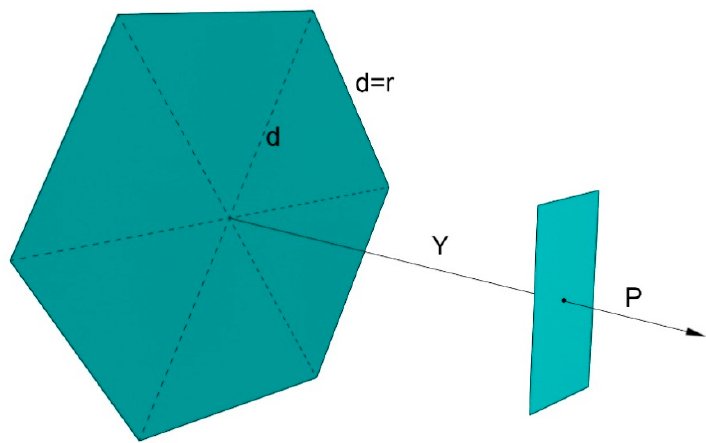
(A7) Figure A2. Configuration factor between an equilateral triangle composed of six rotated triangles and a point in a parallel plane. A.5. Hexagon In the specific case of the hexagon (Figure A3), we would need 12 times the rotated triangle,